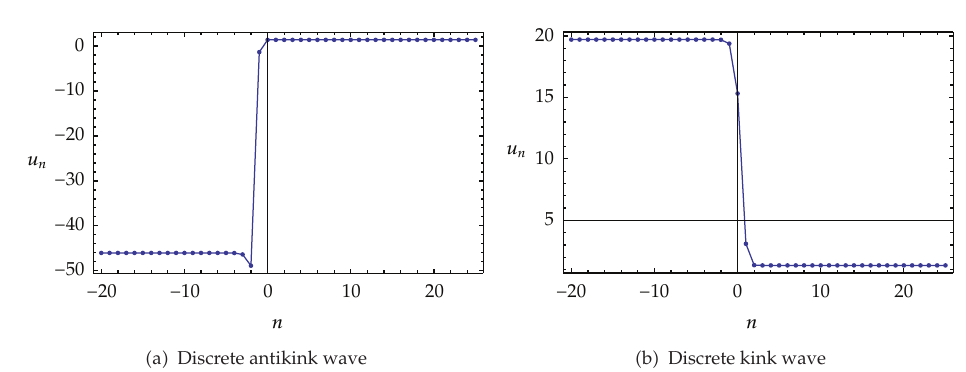
Figure 6: The solution u n in (cid:2) 4.15 (cid:4) shows shapes of discrete antikink and kink